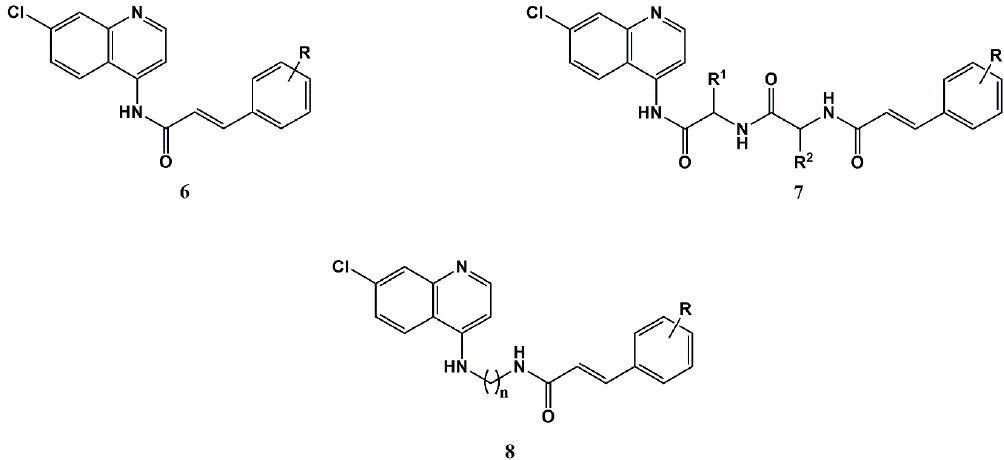
Figure 2. Chloroquine-cinnamic acid conjugates developed by Pérez et al. [53–55,59].